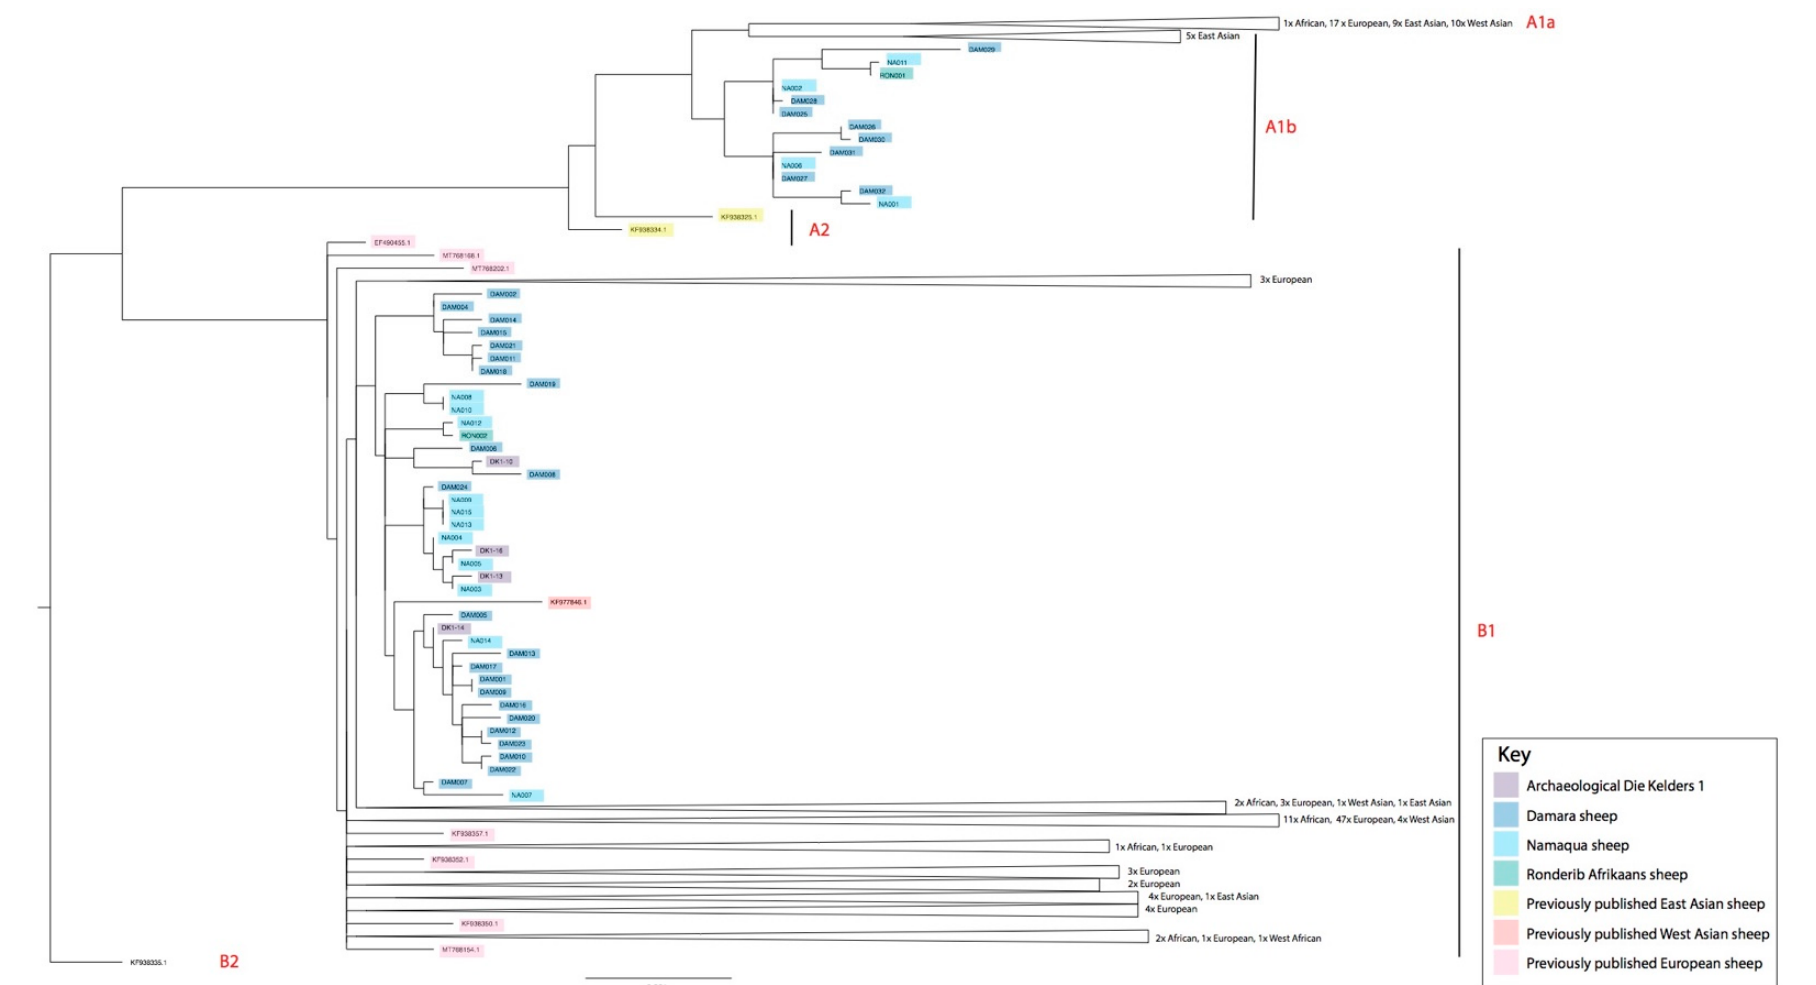
Figure 3. Phylogenetic tree showing sheep from the current study and comparative specimens, showing subhaplogroups A1a, A1b, A2, B1 and B2 (details listed in Supplementary Materials Table S1).